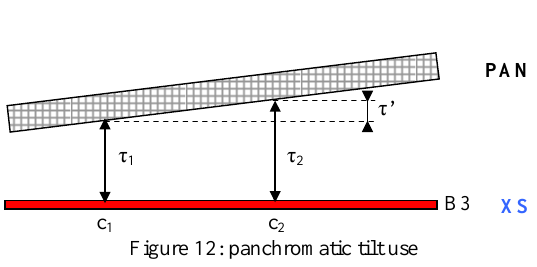
Figure 12: panchromatic tilt use